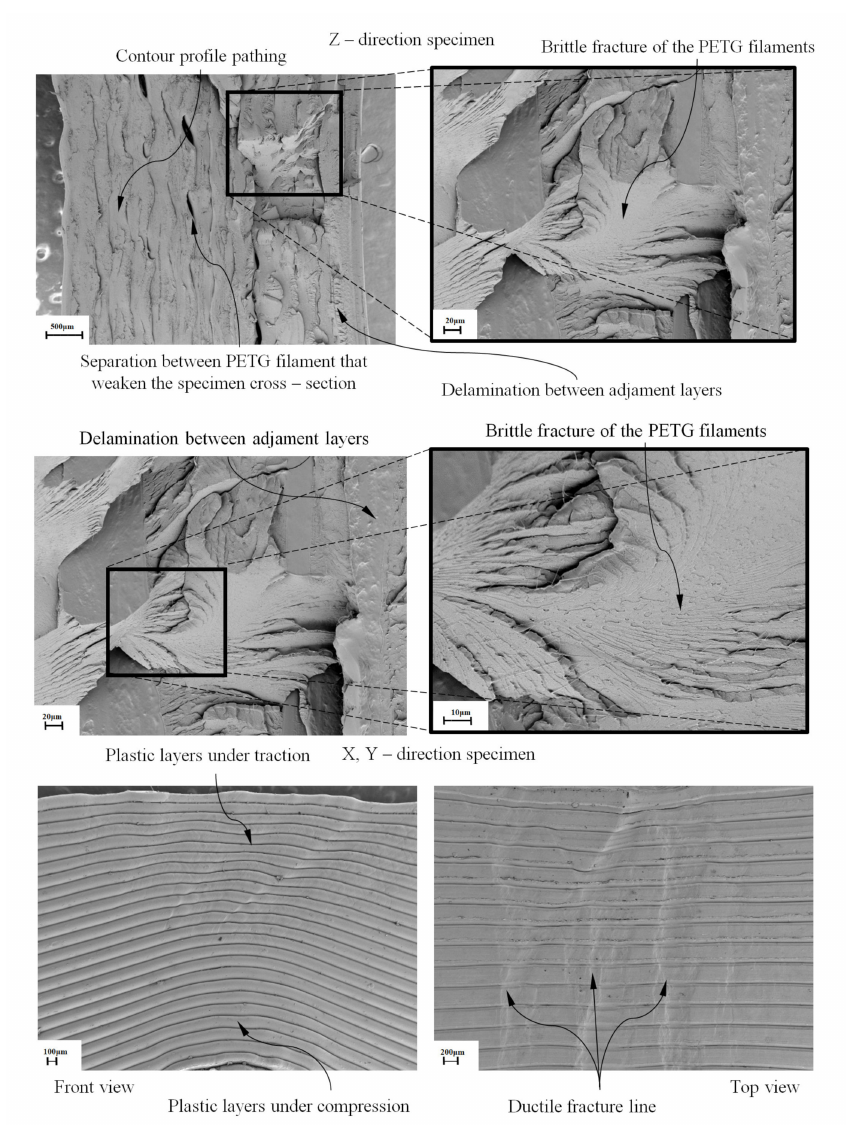
Figure 16. SEM images of the tested